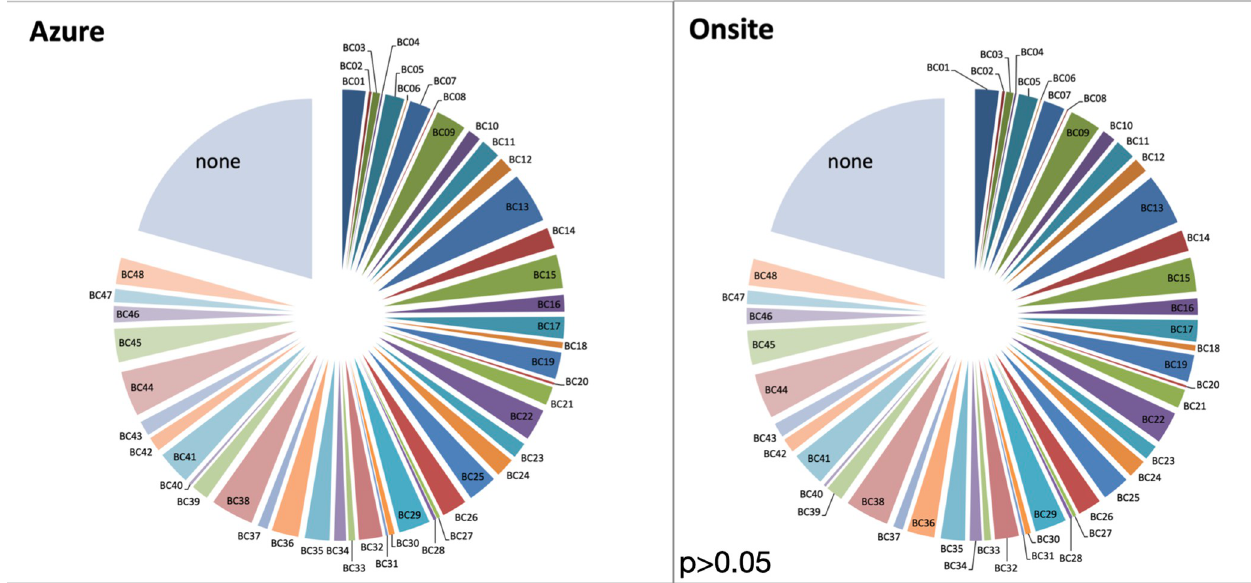
Fig 4. The comparison of sample composition in a sequencing run between the automatic pipeline in the Azure cloud and the manual process onsite.